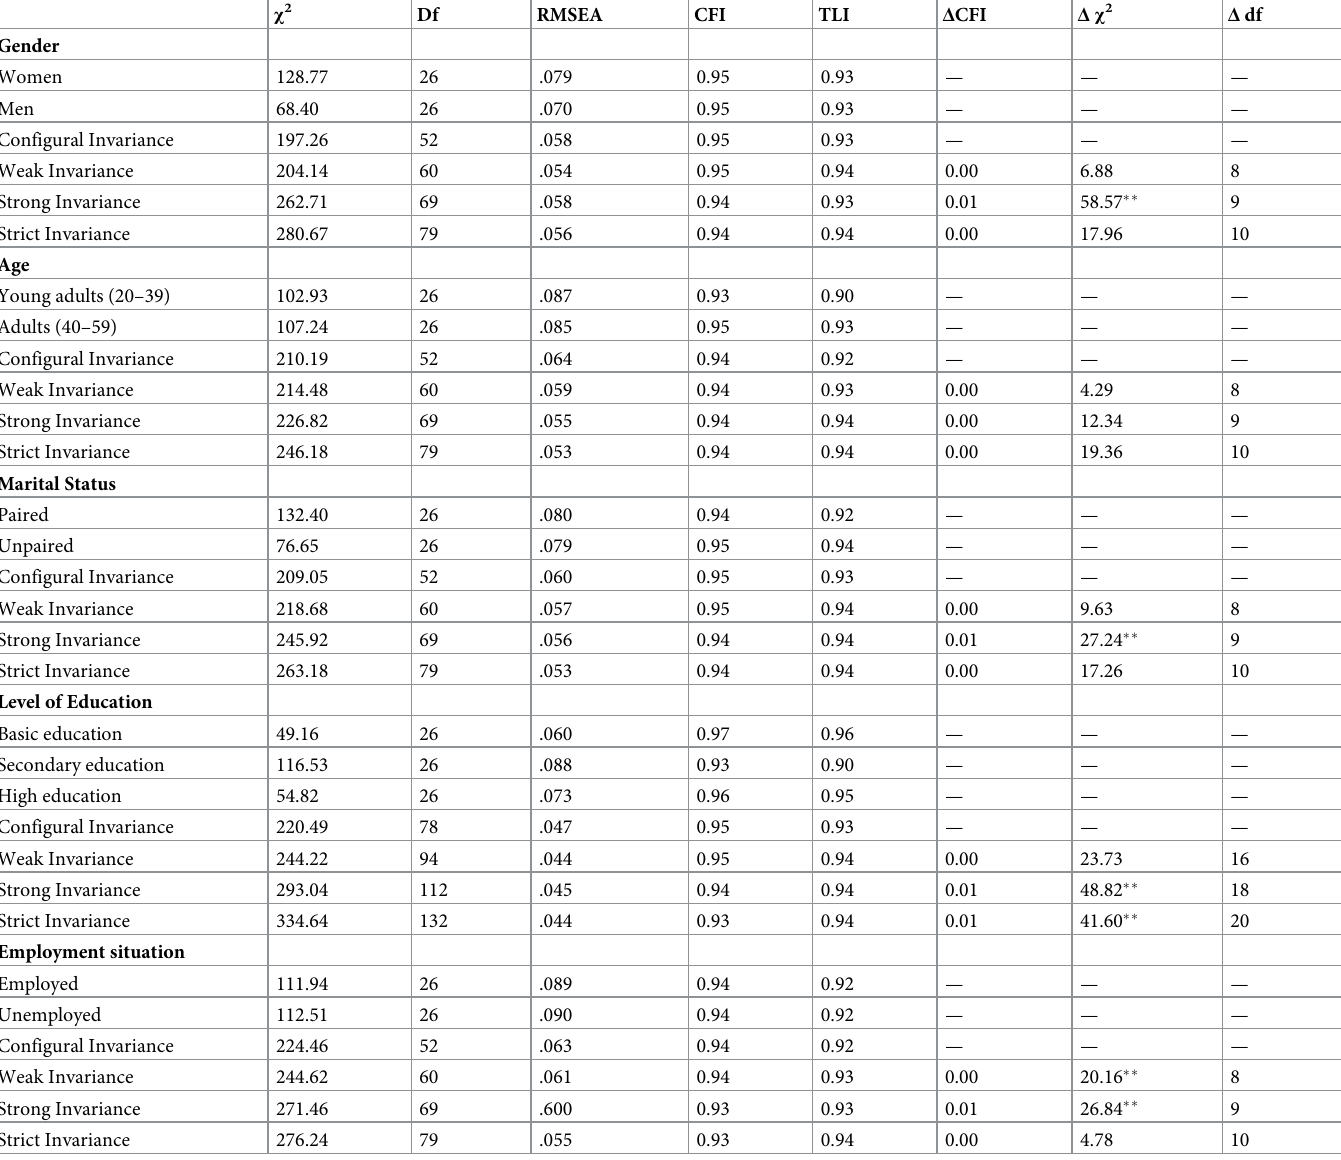
Table 4. Fit statistics for multi-group confirmatory factor analysis by gender, age, marital status, level of education, and employment